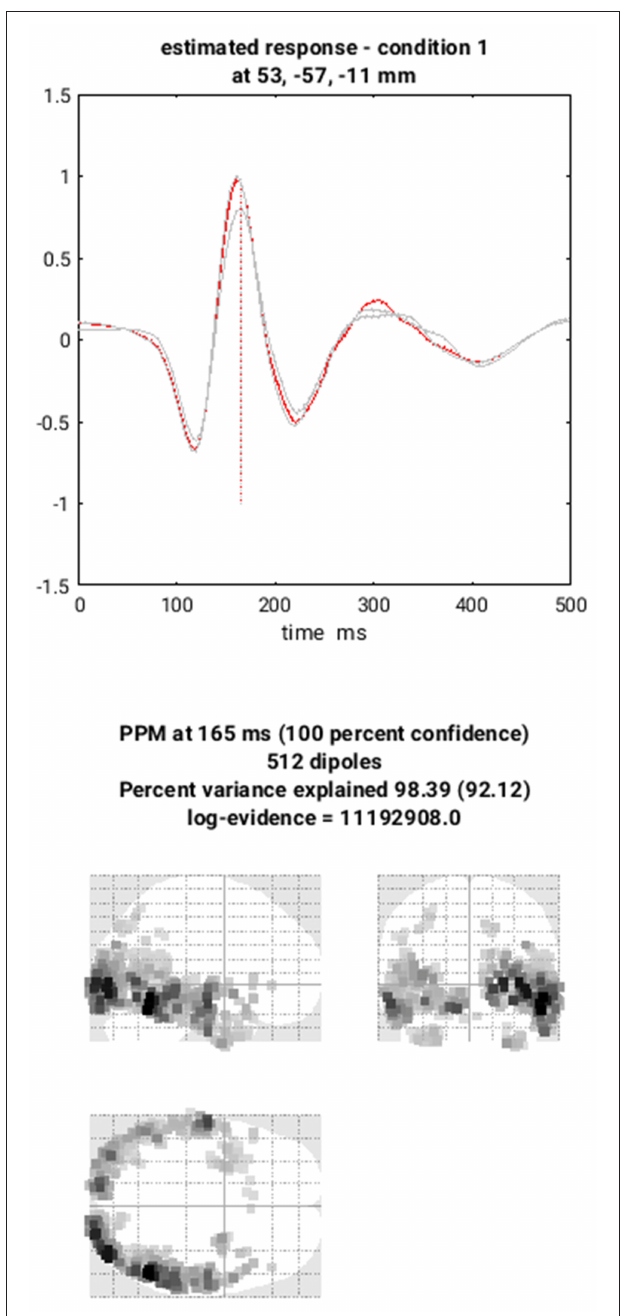
FIGURE 7 | Source solution example MIPs for EEG Modality in subject 15.